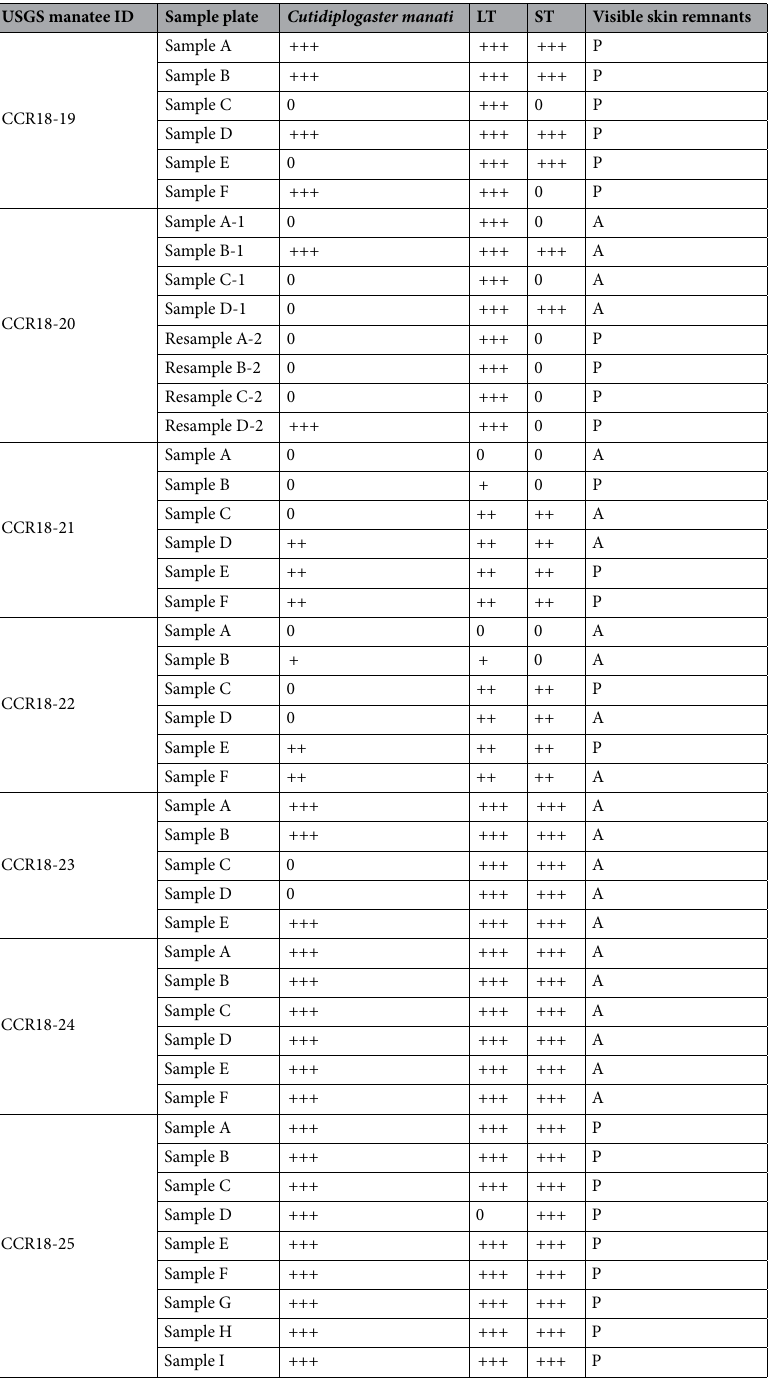
Table 1. Skin sampling results and relative abundance of nematodes on the Florida manatee from Crystal River, Florida during the 2018 health assessments. Estimated measurement of abundance was recorded for each morphospecies observed on each sample plate. This was categorized and recorded as 0 = absent, + = 1–15 nematodes visible,++ = 15–99 nematodes visible, and +++ = 100 or more nematodes visible. Visible skin remnants were categorized as A = absent, or P = present. On manatee CCR18-20, sampling first used minimal pressure (samples A-1 to D-1) and then each location was resampled with increased pressure (samples A-2 to D-2). For all other sampled manatees, each different sample plate represents a pseudoreplicate sample taken from a different arbitrary location near the mid-tail dorsal surface. Samples labelled under a specific manatee ID with a different letter represent a different 5 × 5 cm mid-dorsal tail sampling on the same